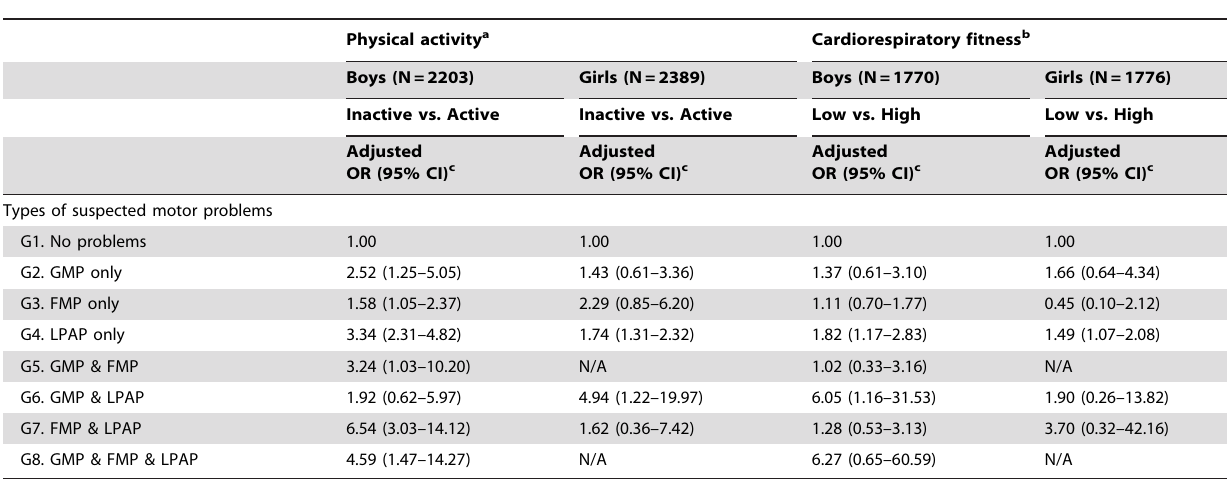
Table 4. Multinomial regression of physical inactivity and low level of cardiorespiratory fitness at age 16 years on different combinations of suspected gross motor problems (GMP), fine motor problems (FMP) and low preference for active play (LPAP) at age 8